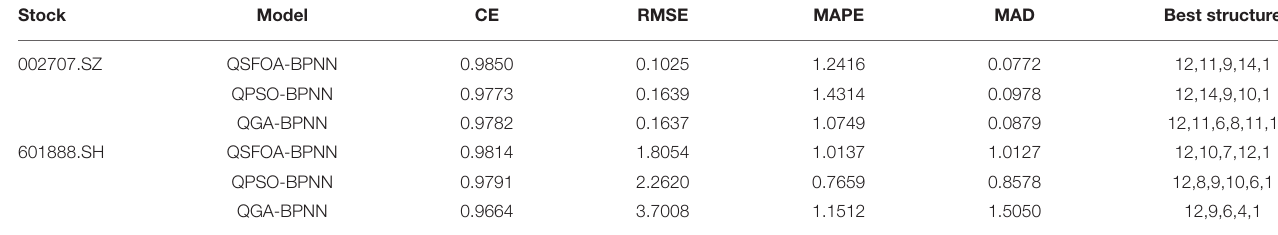
TABLE 3 | Final prediction results of three